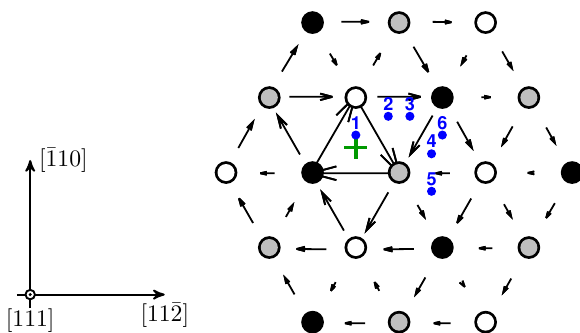
Figure 2. Location of the six nearest tetrahedral sites (blue points) to the geometric center of a screw dislocation core (green cross) before the relaxation of the dislocation–O system with DFT. The dislocation is in an easy core configuration. The arrows represent the amplitude of differential atomic displacements along the (cid:104) 111 (cid:105) direction (normal to the image) induced by the presence of the dislocation. The atoms are color-coded according to their relative position along the [ 111 ] direction (off-plane): white for z = 0, grey for z = b /3 and black for z = 2 b